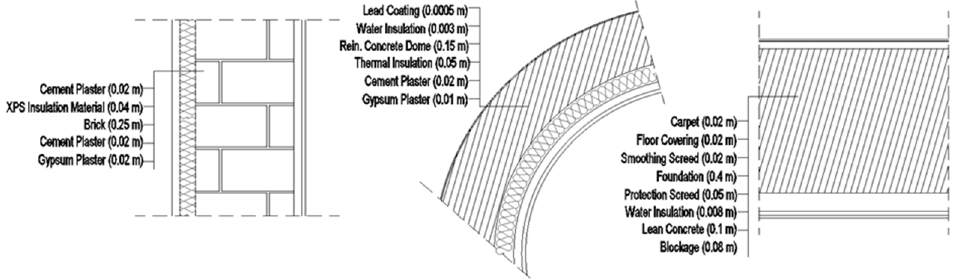
Figure 2. The section properties the building envelope of base mosque scenario.